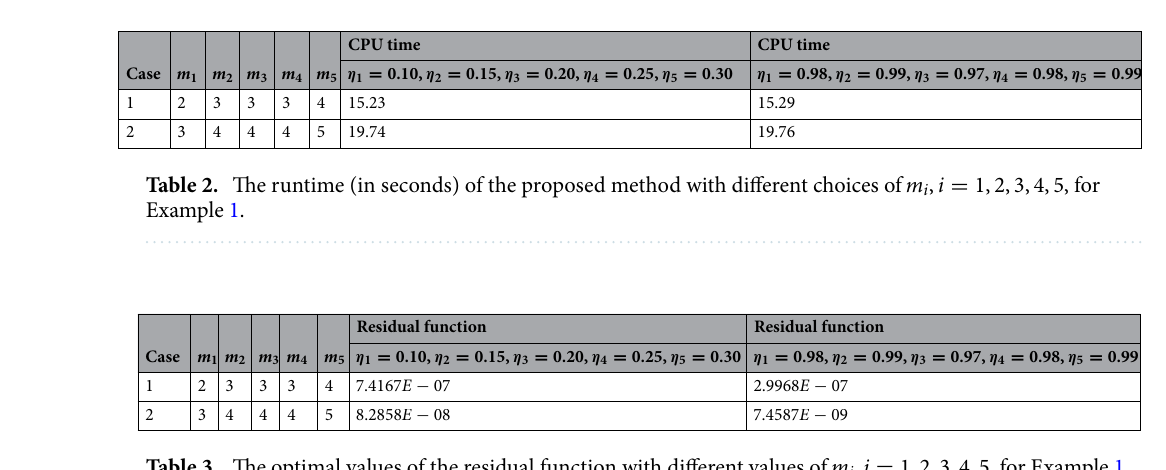
Figure 4. Evolution of { C ( t ) , T ( t ) , H ( t ) , I ( t ) , E ( t ) } vs time for the F-BCCM with m 1 = 3 , m 2 = m 3 = m 4 = 4 and m 5 = 5 , η 1 = 0.98 , η 2 = 0.99 , η 3 = 0.97 , η 4 = 0.98 and η 5 = 0.99 for Example 1.